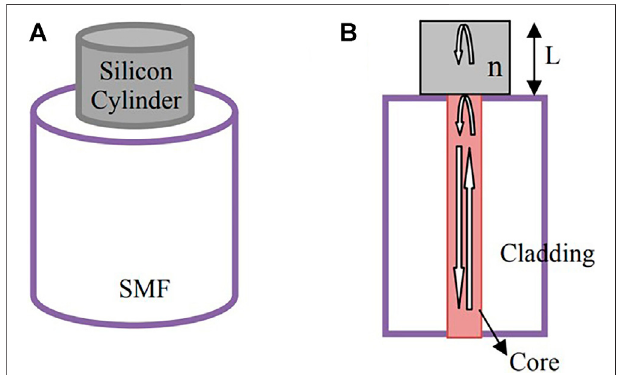
FIGURE 12 | (A) Diagram of sensor probe structure (B) Description of working principle [53]